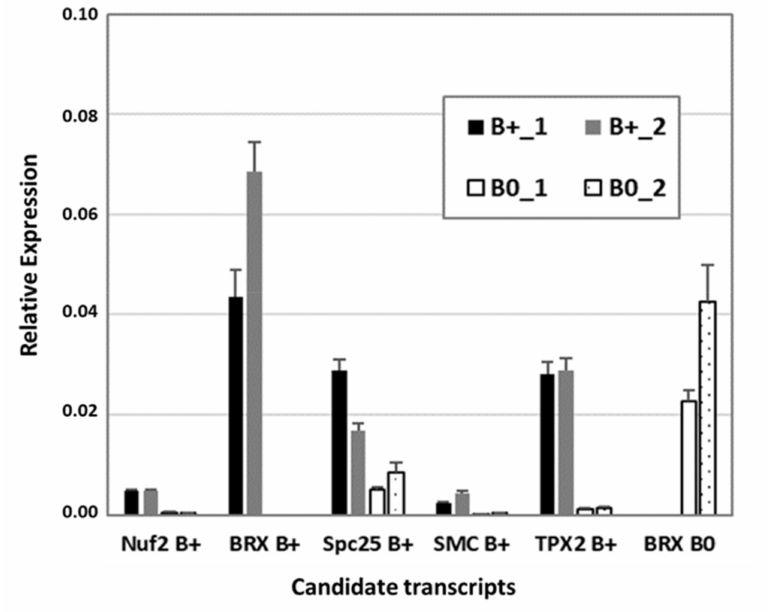
Figure 5. Confirmation of RNA-seq data by RT-qPCR of a subset of di ff erentially expressed transcripts between Bplus (indicated as B + ) and B0 conditions. Transcript levels were determined in two biological replicates of each genotype and normalized to GAPDH. Relative expression and standard deviations are calculated from four replicates ( n =